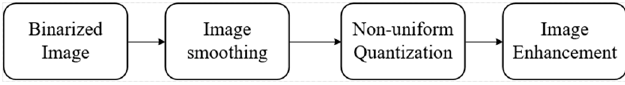
Figure 5. Image processing flow after binarized.